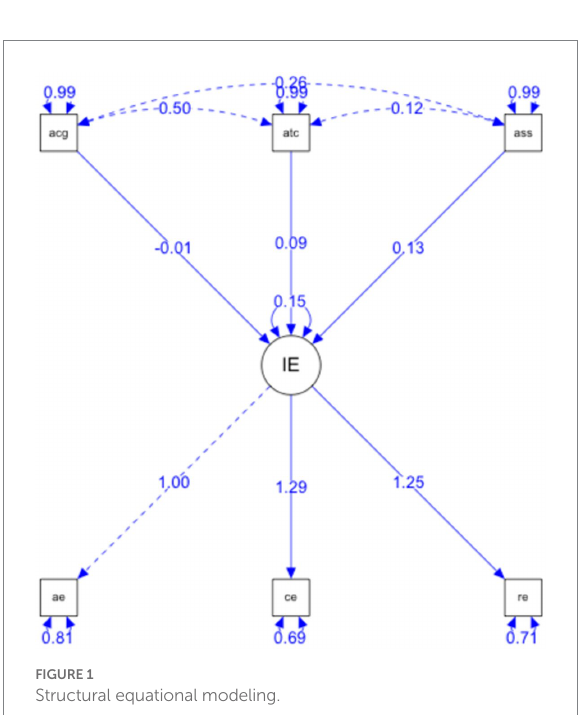
FIGURE 1 Structural equational